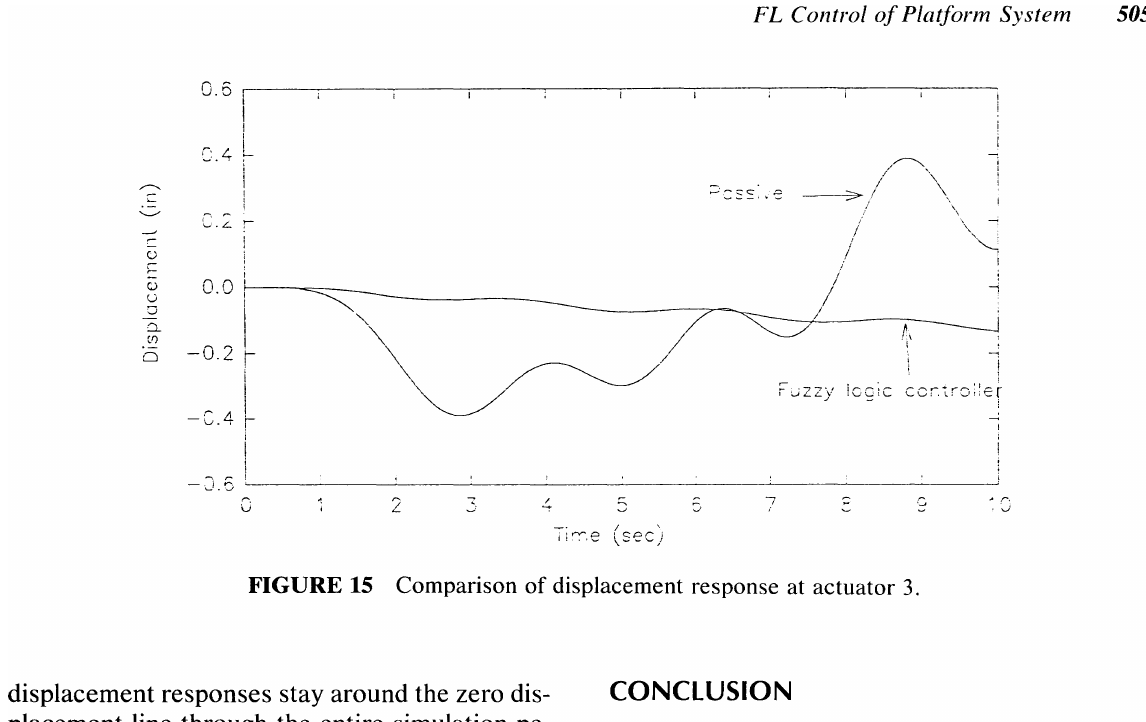
FIGURE 15 Comparison of displacement response at actuator 3.